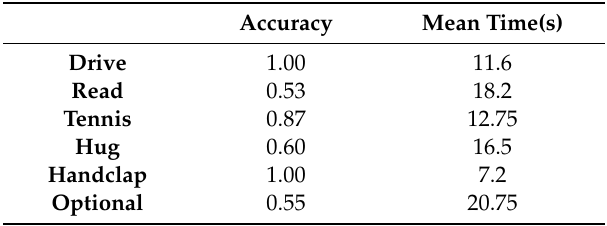
Table 3. Recognition accuracy and mean time of